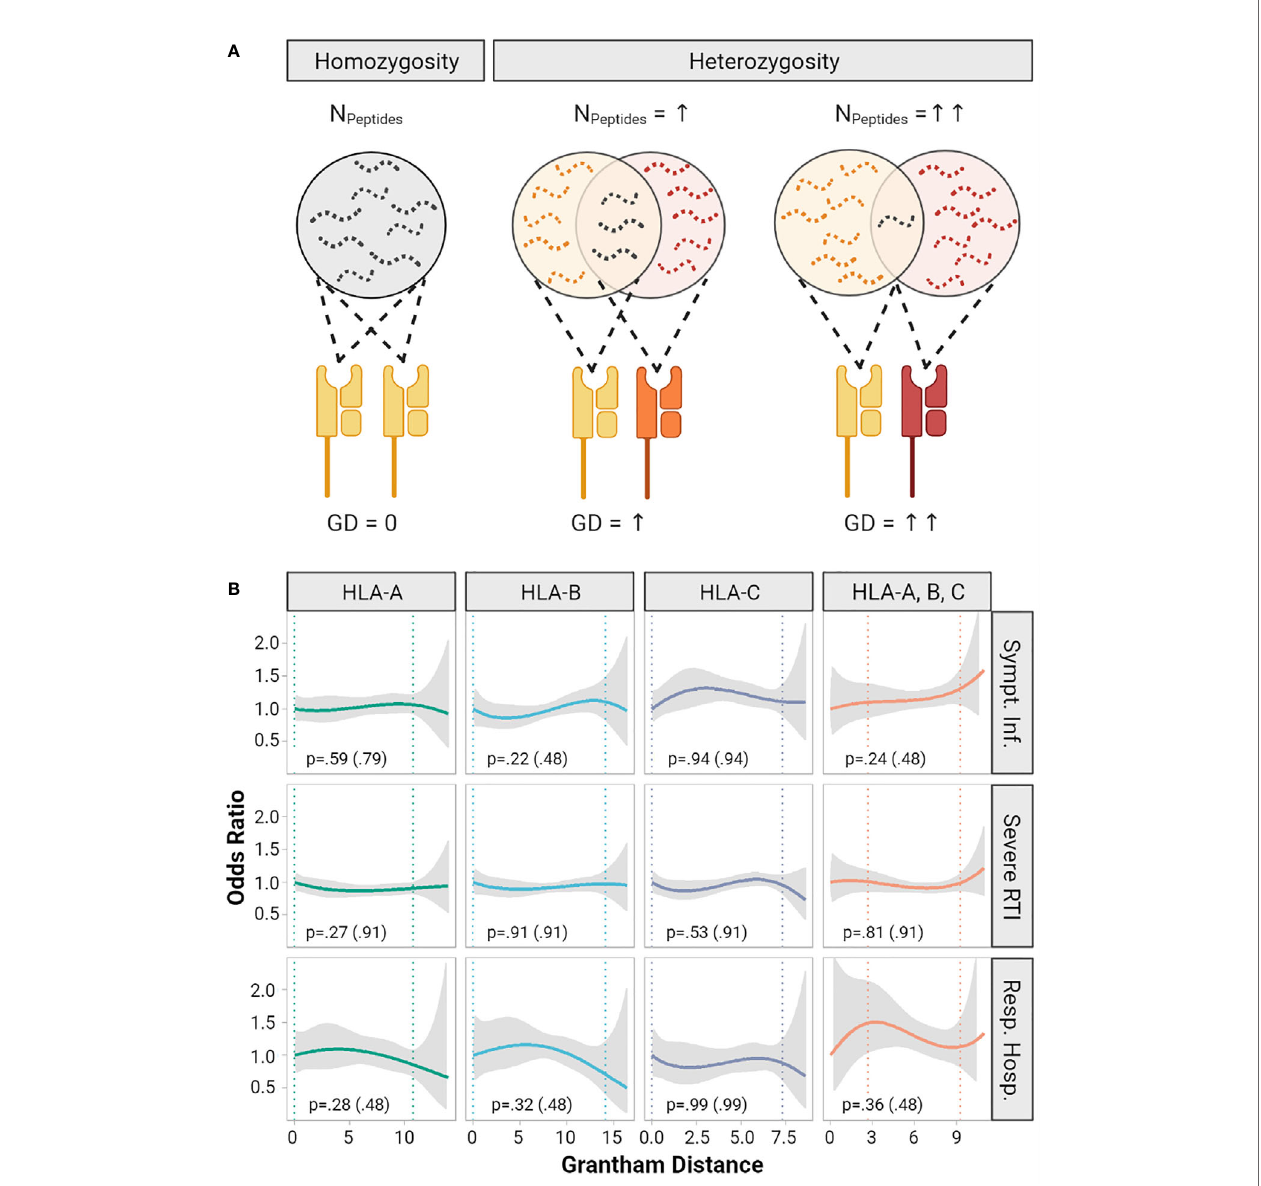
FIGURE 2 | Impact of Grantham Distance of heterozygous HLA-A, - B, -C alleles on COVID-19 severity. (A) The concept of the evolutionary divergence of HLA (HED): For a given HLA-locus the pool of presentable peptides is limited in size and diversity, when both alleles are identical (i.e. homozygous). It gets larger for heterozygous allele combinations and might be largest for two HLA-alleles that show the highest HED. Divergence might be quanti fi ed by the Grantham Distance (GD), a metric based on physicochemical differences of the amino acid sequence of HLA-molecules. Panel (B) shows smoothed plots for the odds ratios (OR) of the risk of symptomatic infection, risk of severe respiratory symptoms (RTI) and risk of respiratory hospitalization depending on the GD of HLA-A, -B, -C and the mean of these three loci. The gray ribbons represent the pointwise 95% con fi dence intervals. Homozygous individuals with a GD of 0 were set as reference (OR = 1). The vertical dotted lines indicate a 90% range of individual ’ s GD by cutting the lowest and highest 5% of GD values observed. The p-values are based on multivariable logistic regression models testing whether a one-unit increase of the Grantham Distance increases the odds ratio. In addition, p values adjusted for multiple testing are provided in